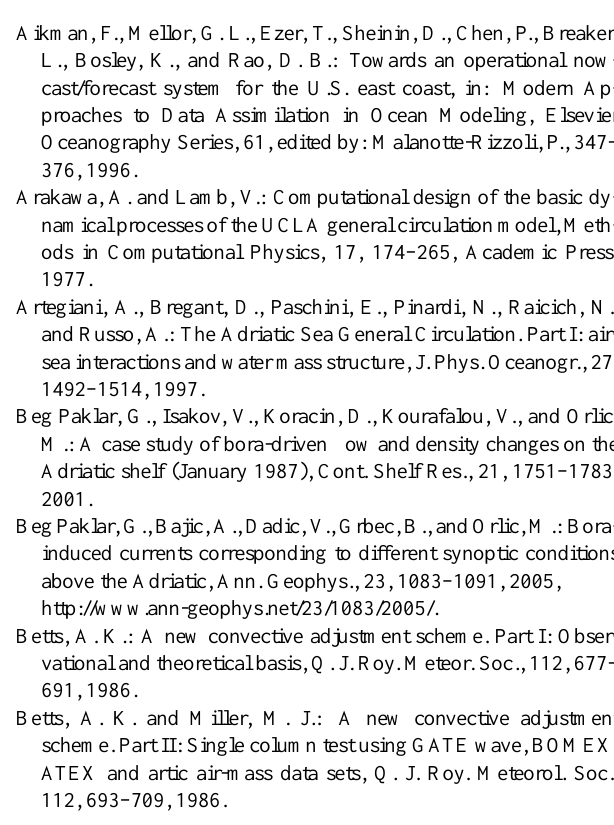
Fig. 16. Verification of wind speed (upper panel) and wind direction (lower panel) with QuickSCAT data. QuickSCAT data are shown in orange, and the model predictions are shown in green. The period of verification was 15–20 February. Mean BIAS for wind speed was approximately −